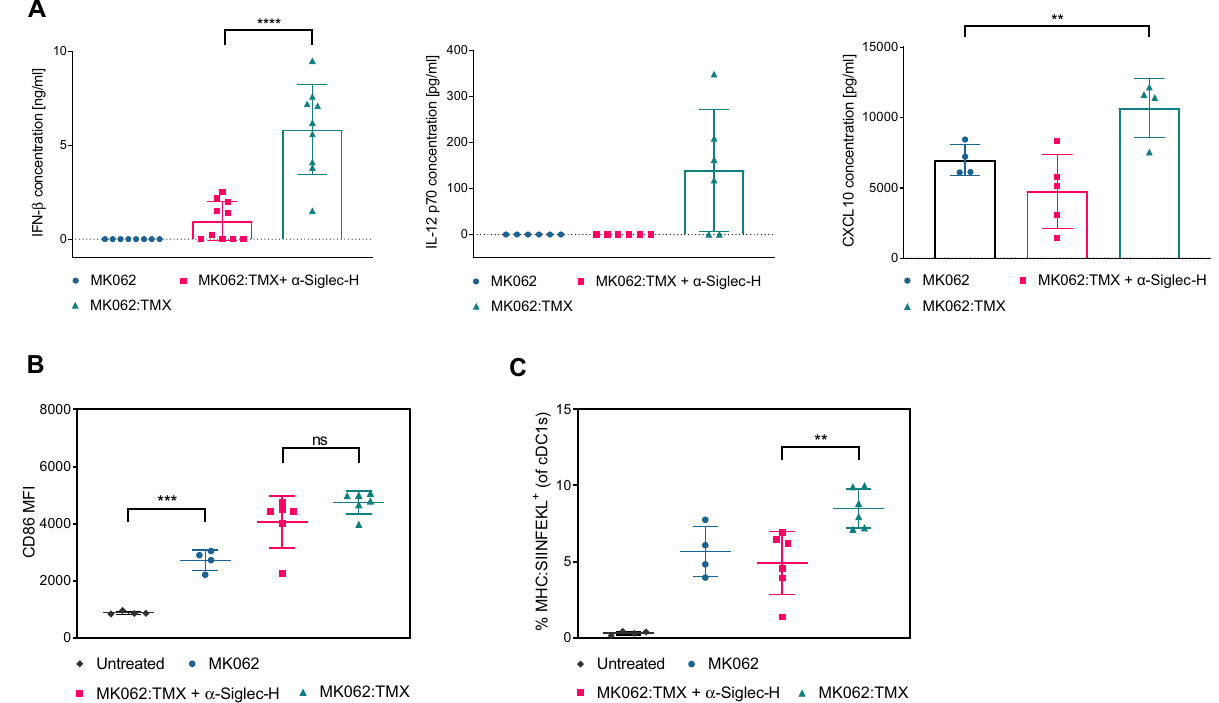
Figure 4. The level of antigen presentation by splenic CD8α + cDCs after MK062:TMX delivery correlates with the secretion of IFN-β by pDCs. ( A ) Effect of pDC blocking on systemic levels of IFN-β, IL-12 p70 and IP-10. Serum levels of cytokines were measured by ELISA four hours after treatment. ( B ) Effect of pDC blocking